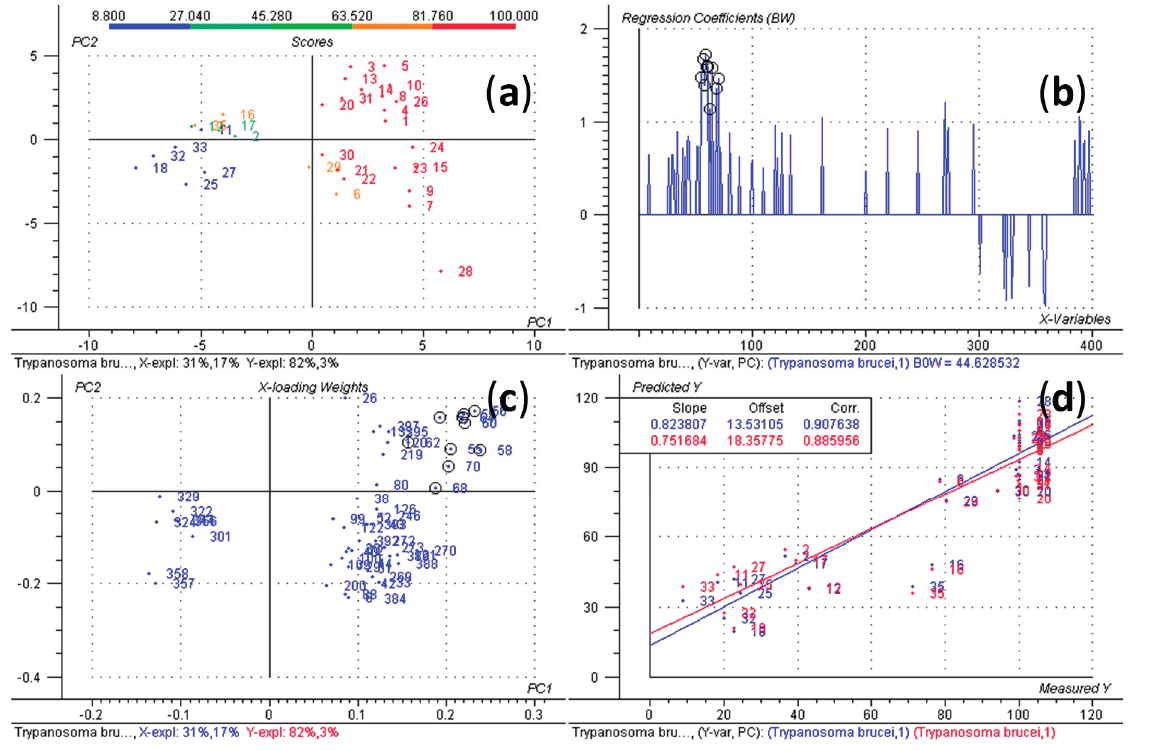
Figure 1. PLS model with activity data against Trypanosoma brucei rhodesiense . Numbers in scores plot ( a ) and response plot ( d ) relate to samples numbers of Table 1. Colour code in ( a ) indicates the samples’ inhibitory activity from the lowest (8.8%, blue) to the highest value (100%, red). Red colour in ( d ) indicates cross-validated data. Numbers in regression coefficient plot ( b ) and loadings plot ( c ) relate to bucket numbers. Buckets representing ( 1 ) are highlighted by circles. Table 2. Signals of the mass spectrum of ( 1 ) (sample No. 28) and related buckets as identified by PLS. All fragment ions were confirmed by MS/MS of m / z 339 [M + H] + . Mass Spectrum of (1) m / z (Rel.